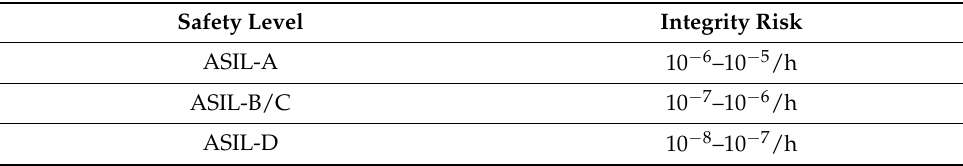
Table 3. ISO 26262 ASIL safety level and integrity